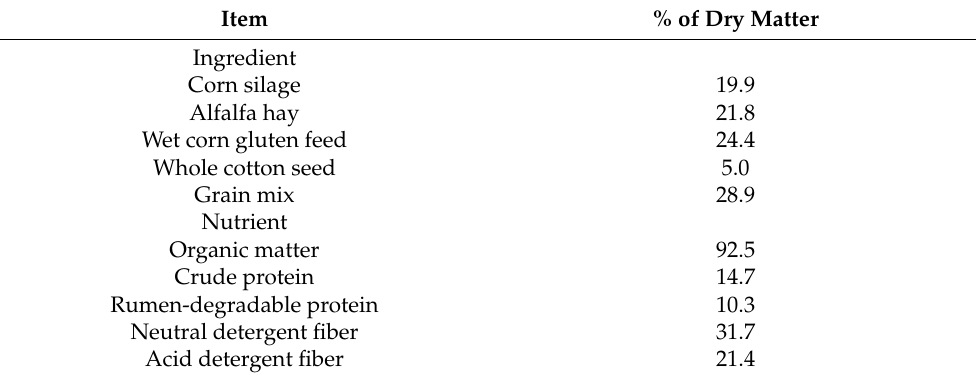
Table 1. Composition of experimental diet.